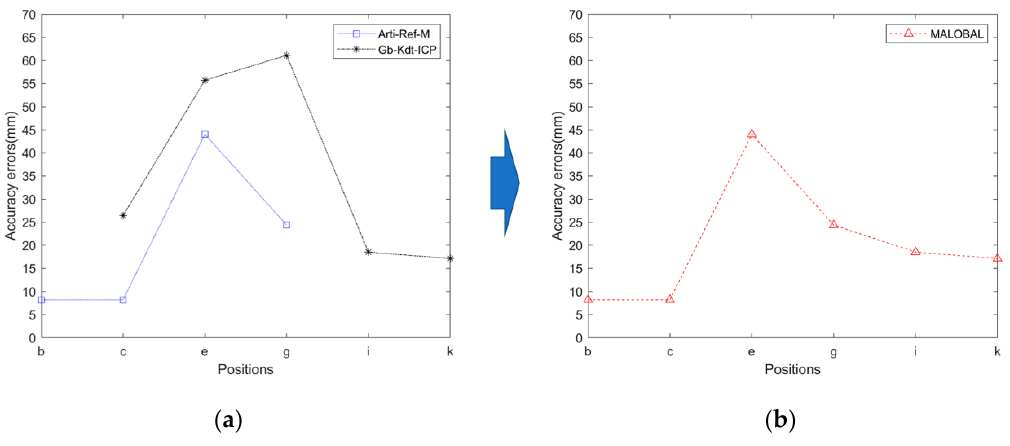
Figure 11. Localization errors of mobile robot at different operating locations (b-k). ( a ) The accuracy errors of two methods of Arti-Ref-M and Gb-Kdt-ICP; ( b ) The accuracy error of MALOBAL method that proposed in the paper.